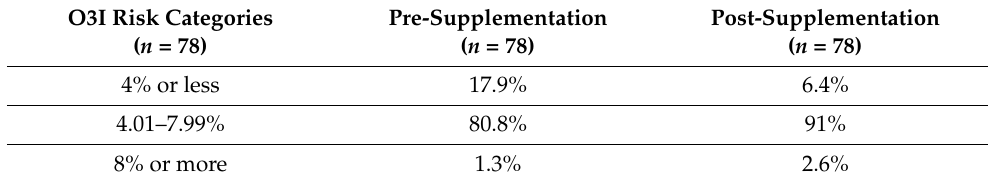
Figure 1. Boxplot illustrating the distributions of pre- and post-supplementation Omega-3 Index for the full sample and stratified by supplementation duration. Table 2. Percentage of participants in the O3I risk categories pre - and post - supplementation. Table 2. Percentage of participants in the O3I risk categories pre- and